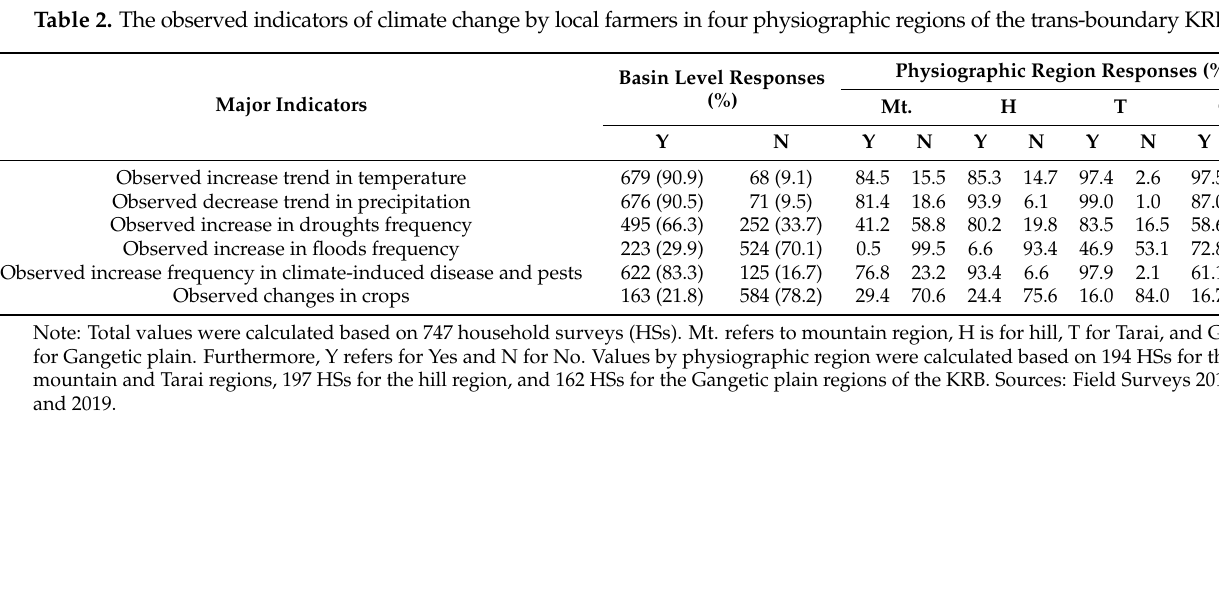
Basin Level Responses (%)